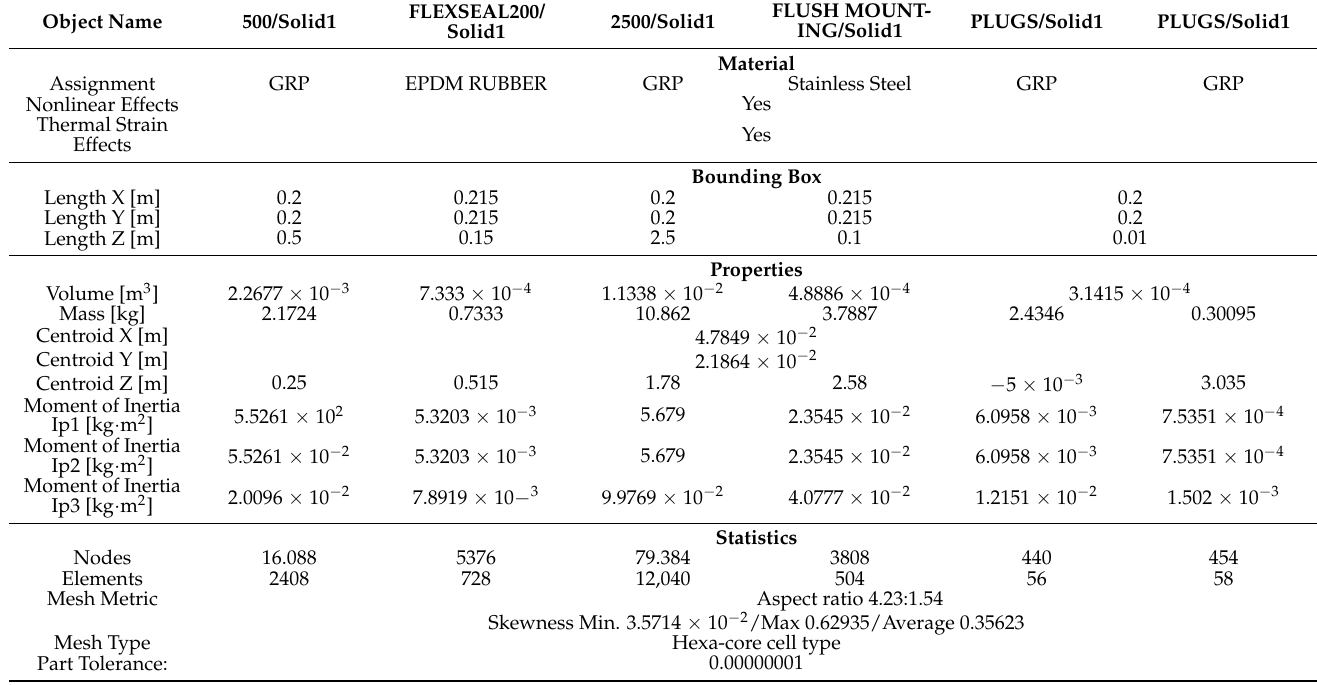
Table 3. System geometry and characteristics.